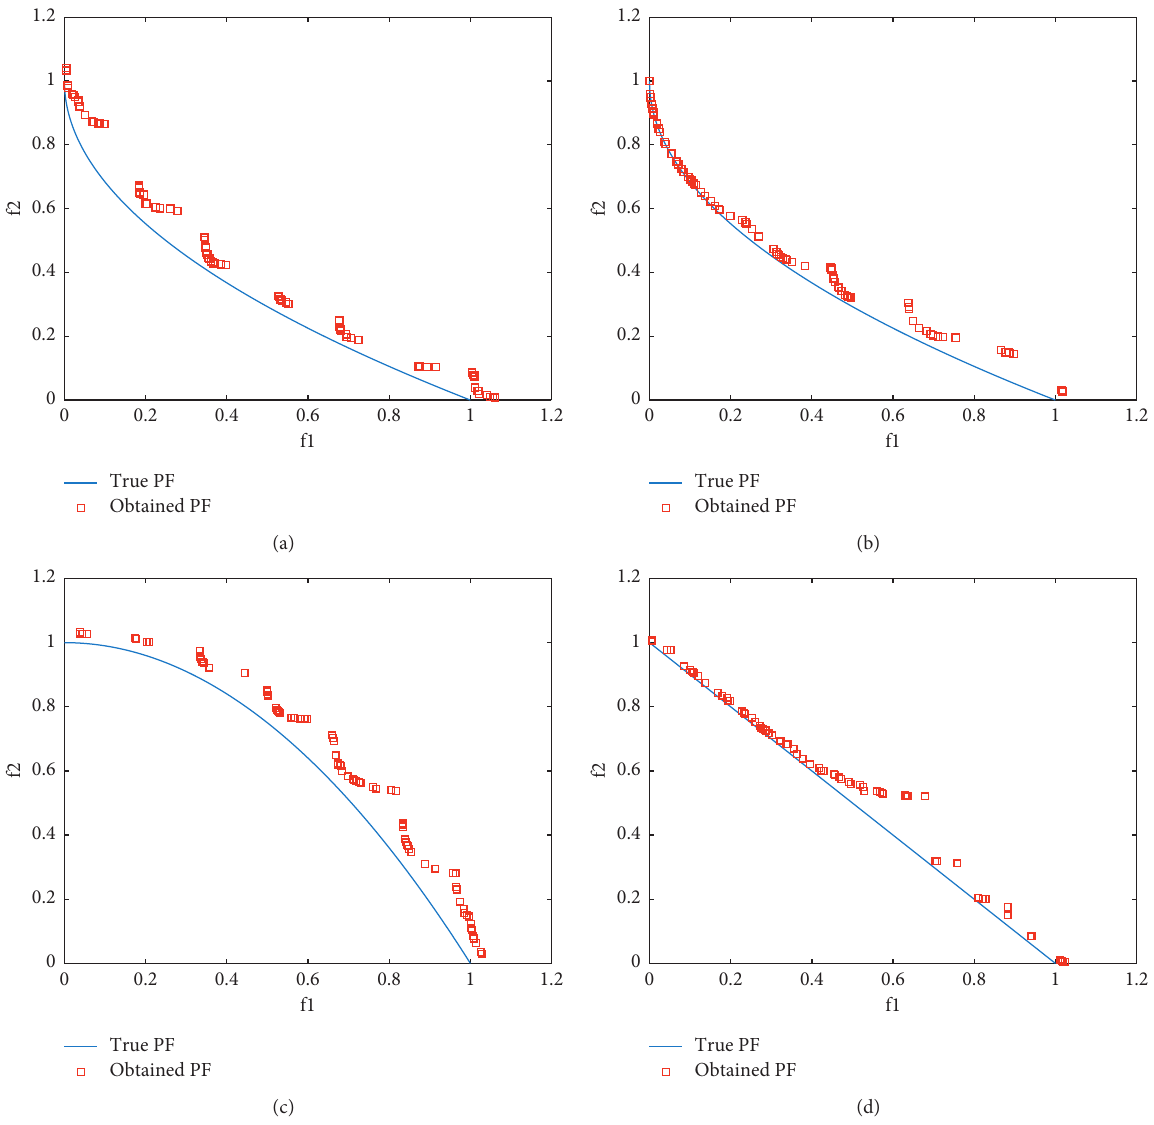
Figure 5: Pareto-optimal solutions obtained by HMOHHO for UF1, UF2, UF4, and UF7. (a) HMOHHO for UF1 problem, (b) HMOHHO for UF2 problem, (c) HMOHHO for UF4 problem, and (d) HMOHHO for UF7